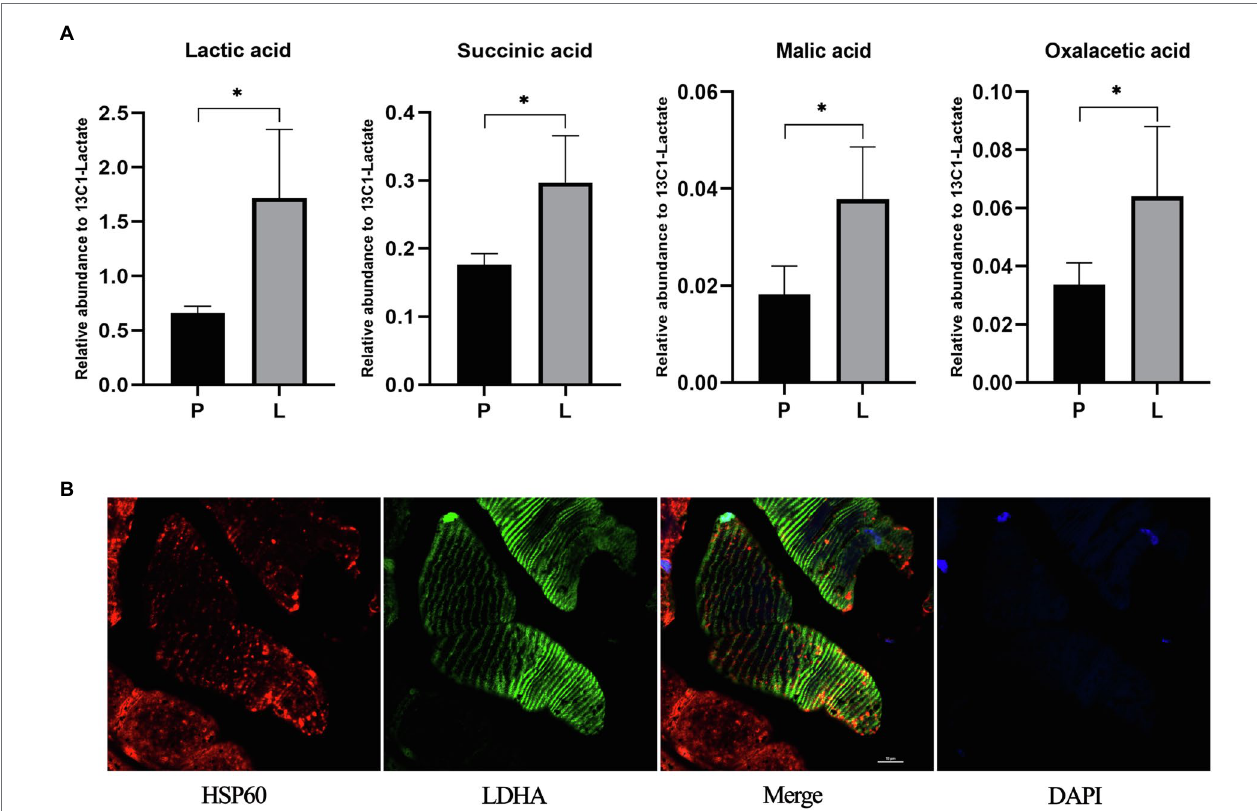
FIGURE 9 | The contents of lactic acid and TCA related metabolites in mitochondria after acute lactate injection and the colocalization of mitochondria and LDHA. (A) The relative abundance of Lactic acid, Succinic acid, Malic acid, and Oxalacetic acid in mitochondria. P: after acute PBS injection ( n = 3); L: after acute lactate injection ( n = 3). The data are presented as the mean ± SD, and significant differences between the two groups were analyzed with the independent-samples t -test. * p < 0.05. (B) Confocal laser scanning microscopic imaging of immunolabeled LDH (green), and HSP60 (red). Antibodies against HSP60 were used as a label of the mitochondria.